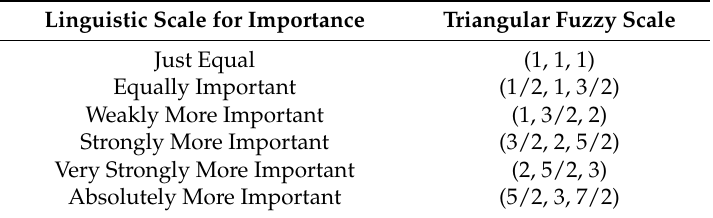
Table 2. The linguistic fuzzy scales for importance of flood hazard and social vulnerability factors.